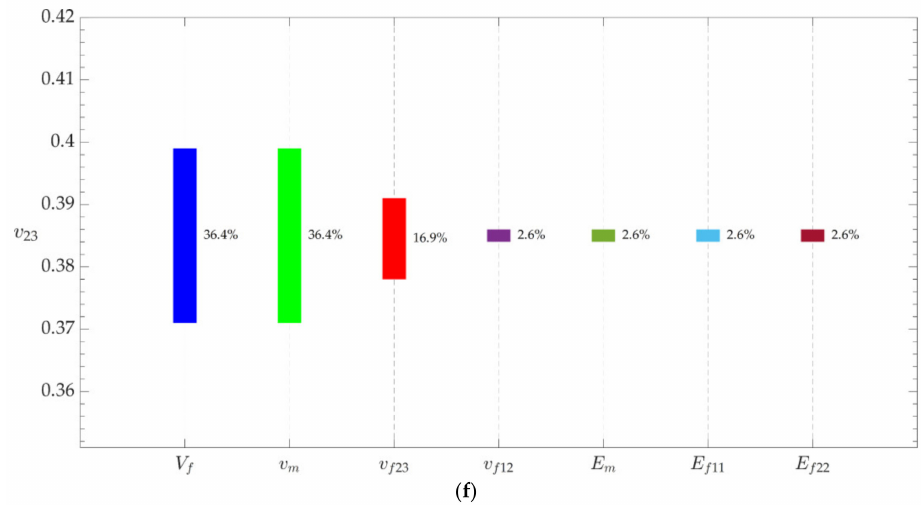
Figure 2. The effect of input parameters on the range of ( a ) the E 11 , ( b ) the E 22 , ( c ) the G 12 , ( d ) the G 23 , ( e ) the ν 12 , and ( f ) the ν 23 for the AS4-3501/6 composite ply. The main parameter varied within ± 5% of its nominal value while the other parameters were kept equal to the nominal value.